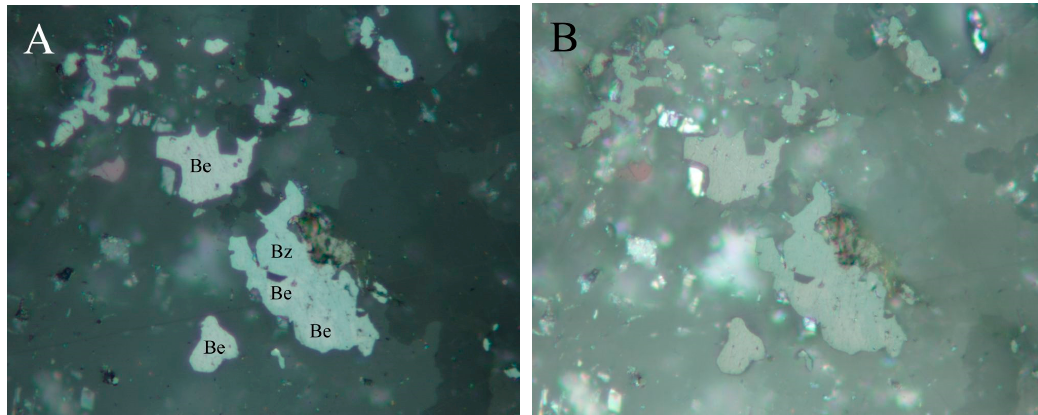
( A ) one polarizer, and ( B ) partly-crossed polarizers. Field of view 210 μ m. P ř íbram, from a dump of shaft 16. Photo by P. Škácha.